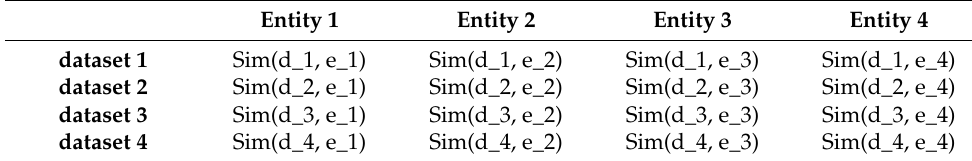
Table 2. Datasets to entities